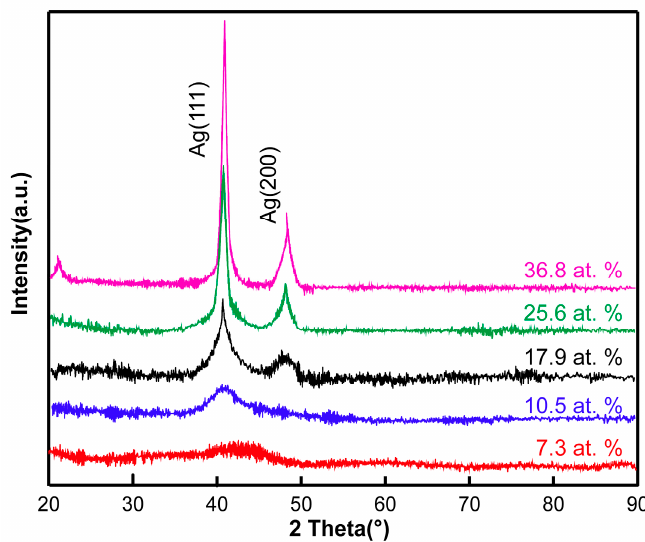
ff Figure 3. XRD diffraction patterns of Ag-doped diamond-like carbon (Ag-DLC) films with 5 Ag Figure3. XRDdi